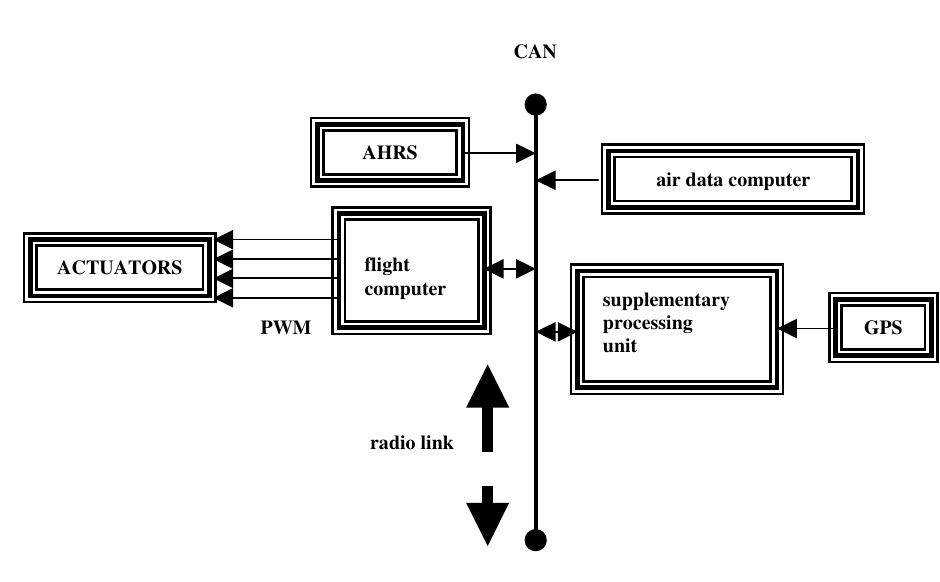
Fig 4. Logical structure of